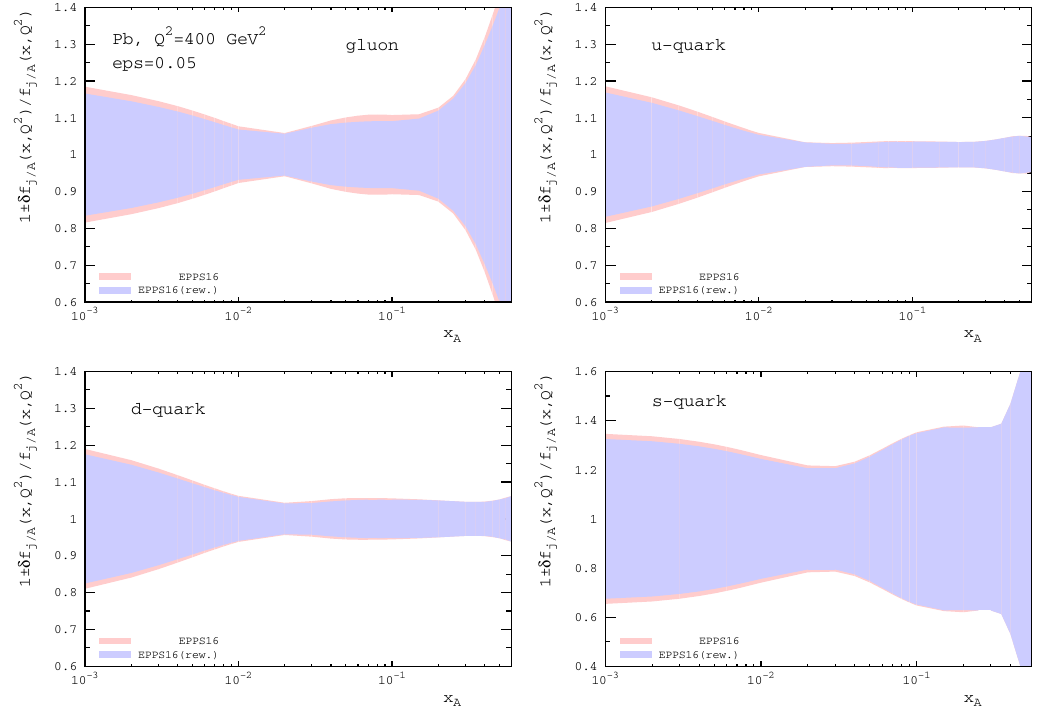
Fig. 10 The gluon, u -quark, d -quark, and s -quark EPPS16 nPDFs as a function of x at Q 2 = 400 GeV 2 with (blue, inner band) and without (red, outer band) the Bayesian reweighting. The case of (cid:6) = 0 .